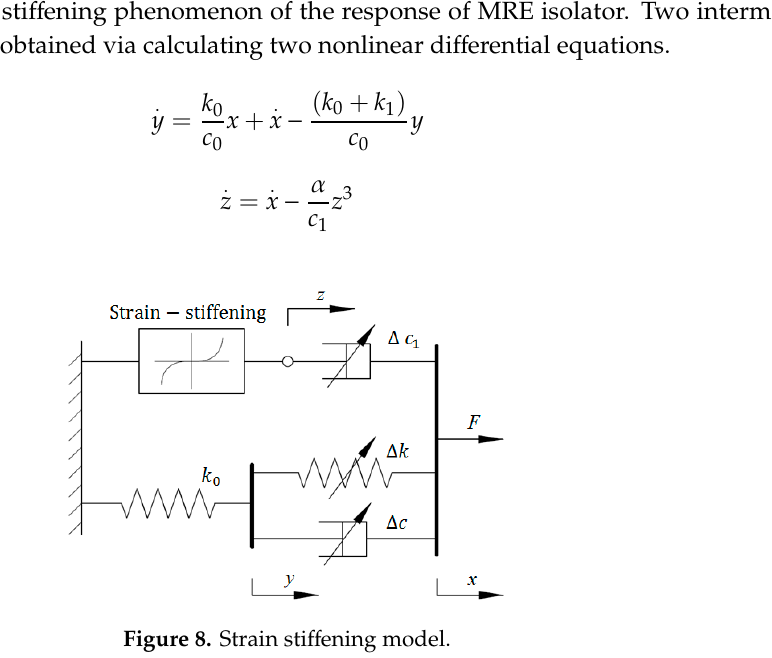
Figure 9. Hyperbolic hysteresis model.